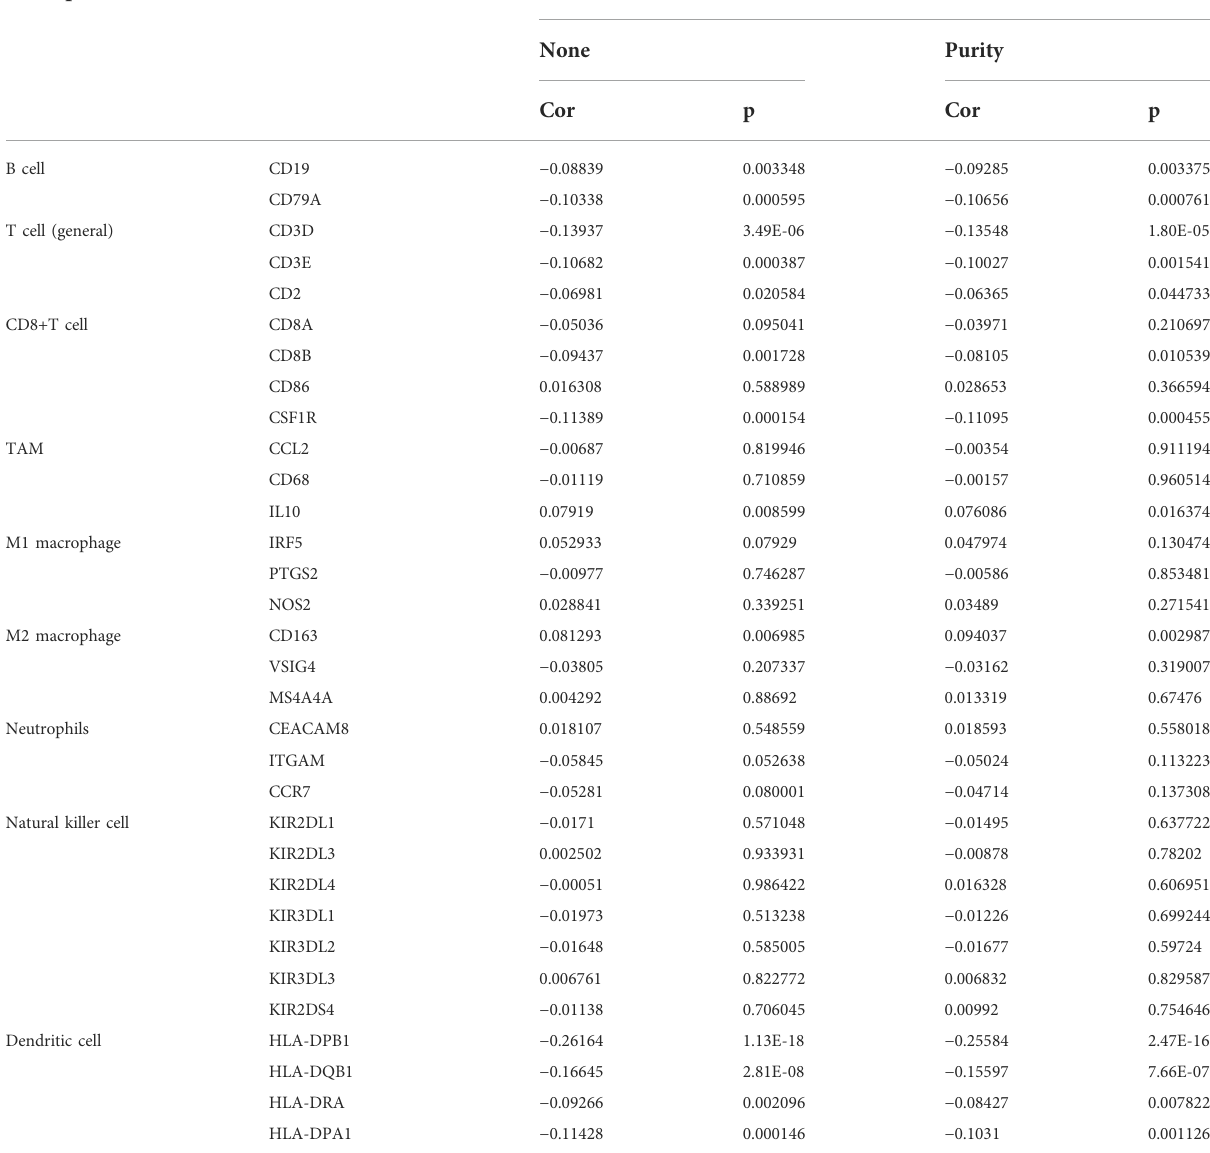
TABLE 1 Correlation analysis between PTK2 and gene markers of immune cells in breast cancer by